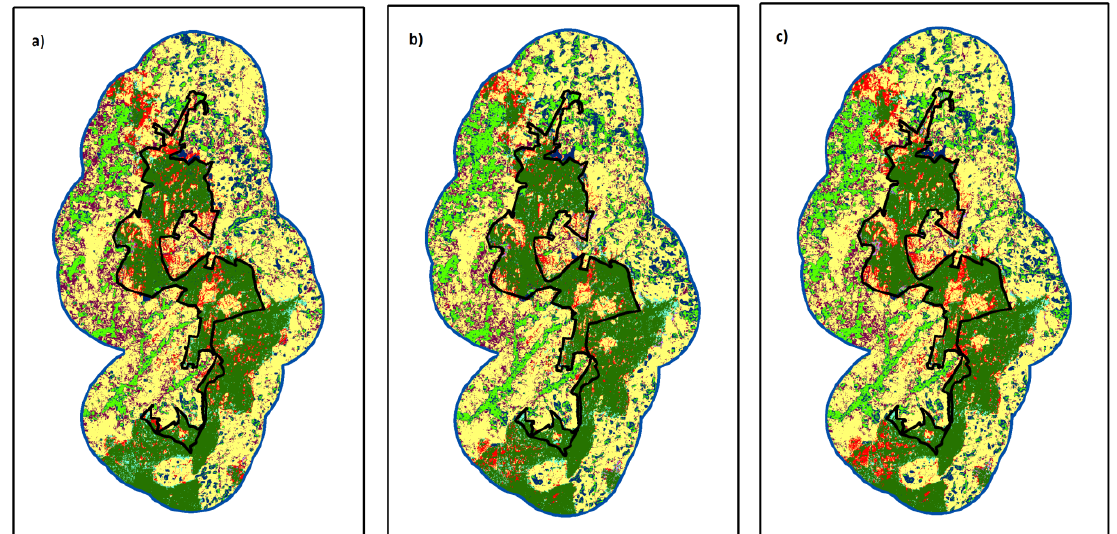
Figure 8. Validation maps of observed land cover vs. predicted land cover for dates ( a ) 2007 –2007 , ( b ) 2007 –2007 , ( c ) 2007 –2007 and ( d ) 1999 –1999 . obs pred1 obs pred2 obs pred3 obs pred4 Observed land-covers for a given year is denoted by ‘obs’ and predicted land-covers for a given year is denoted by